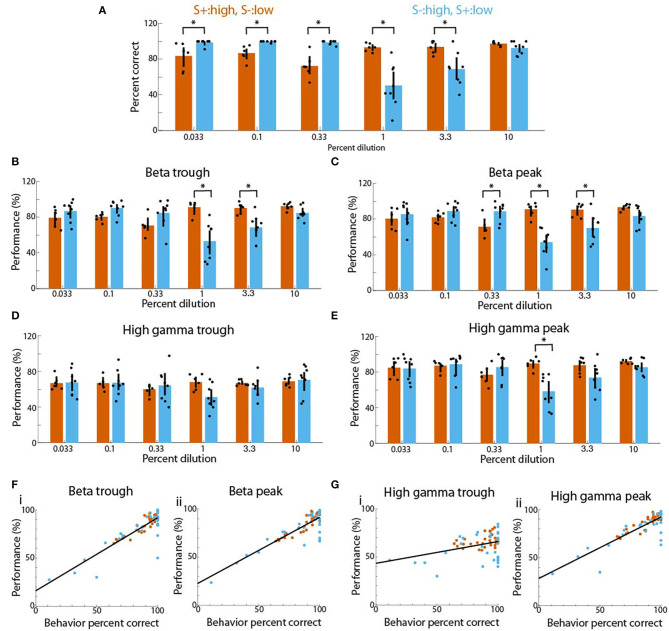
Linear relationship between tPRP decoding performance and behavioral percent correct for mice proficient in the go-no go concentration task. (A) Behavioral percent correct as a function of concentration shown for sessions where the high concentration range was rewarded (vermillon) and sessions where the low concentration range was rewarded (sky blue). A GLM analysis indicates that there was a significant difference for the interaction between reward for high vs. low concentration and odorant dilution (p < 0.001, 84 observations, 80 d.f., F-statistic 4.98, p < 0.01, n = 6 mice). Asterisks denote significant differences between the two sessions differing in rewarded stimulus tested post-hoc with either t or ranksum tests corrected for multiple comparisons (p < pFDA = 0.023). B and C. Performance for decoding the rewarded stimulus from the tPRP for beta oscillations. (B) shows results for trough-referenced tPRP and (C) shows decoding for peak-referenced tPRP. For the trough-referenced tPRP a GLM analysis indicated that there was a significant difference for reward for high vs. low concentration (p < 0.05) and odorant dilution (p < 0.05) for the interaction between reward for high vs. low concentration and odorant dilution (p < 0.01, 84 observations, 80 d.f., F-statistic 4.7, p < 0.01, n = 6 mice). Asterisks denote significant differences between the two sessions differing in rewarded stimulus tested post-hoc with either t or ranksum tests corrected for multiple comparisons (p < pFDA = 0.017). For the peak-referenced tPRP a GLM analysis indicated that there was a significant difference for reward for high vs. low concentration (p < 0.01) and odorant dilution (p < 0.05) for the interaction between reward for high vs. low concentration and odorant dilution (p < 0.01, 84 observations, 80 d.f., F-statistic 4.7, p < 0.01, n = 6 mice). Asterisks denote significant differences between the two sessions differing in rewarded stimulus tested post-hoc with either t or ranksum tests corrected for multiple comparisons (p < pFDA = 0.016). (D,E) Performance for decoding the rewarded stimulus from the tPRP for gamma oscillations. (D) shows results for trough-referenced tPRP and E shows decoding for peak-referenced tPRP. For the trough-referenced tPRP a GLM analysis indicated that there were no statistical differences (p > 0.05, 84 observations, 80 d.f., F-statistic 0.37, p > 0.05, n = 6 mice) and there were no significant differences in post-hoc t or ranksum tests corrected for multiple comparisons (p < pFDA = 0.0004). For the peak-referenced tPRP a glm analysis indicated that there was a significant difference for reward for high vs. low concentration (p < 0.01, 84 observations, 80 d.f., F-statistic 2.8, p < 0.05, n = 6 mice). The asterisk denotes a significant difference between the two sessions differing in rewarded stimulus tested post-hoc with a t-test corrected for multiple comparisons (p < pFDA = 0.002). (F,G) Relationship between tPRP stimulus decoding performance and percent correct for the percent correct responses in the go-no go concentration task plotted for all concentrations for sessions where the high concentration range was rewarded (vermillon) and sessions where the low concentration range was rewarded (sky blue) (only mice that were tested in both types of sessions were included, n = 5 mice). (F) Performance of beta tPRP. (G) Performance of gamma tPRP. (i) trough-referenced tPRP, (ii) peak referenced tPRP. Lines are linear best fits. A linear correlation analysis yielded the following correlation coefficients (rho) and p-values: Fi. rho 0.86, p < 0.001, Fii. rho 0.85, p < 0.001, Gi. rho 0.36, p < 0.01, Gii. rho 0.84, p < 0.001.